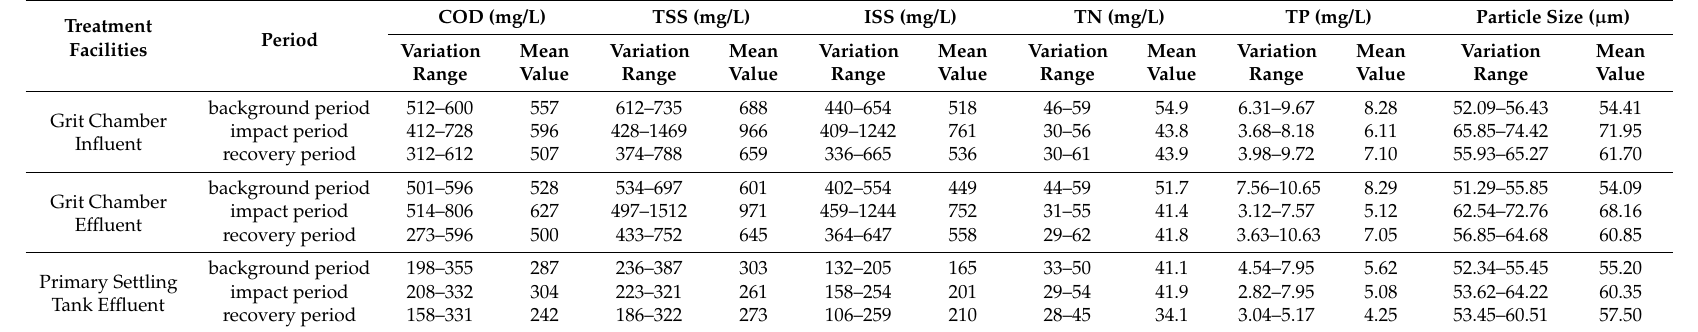
Table 1. Variation range and mean value of pollutant